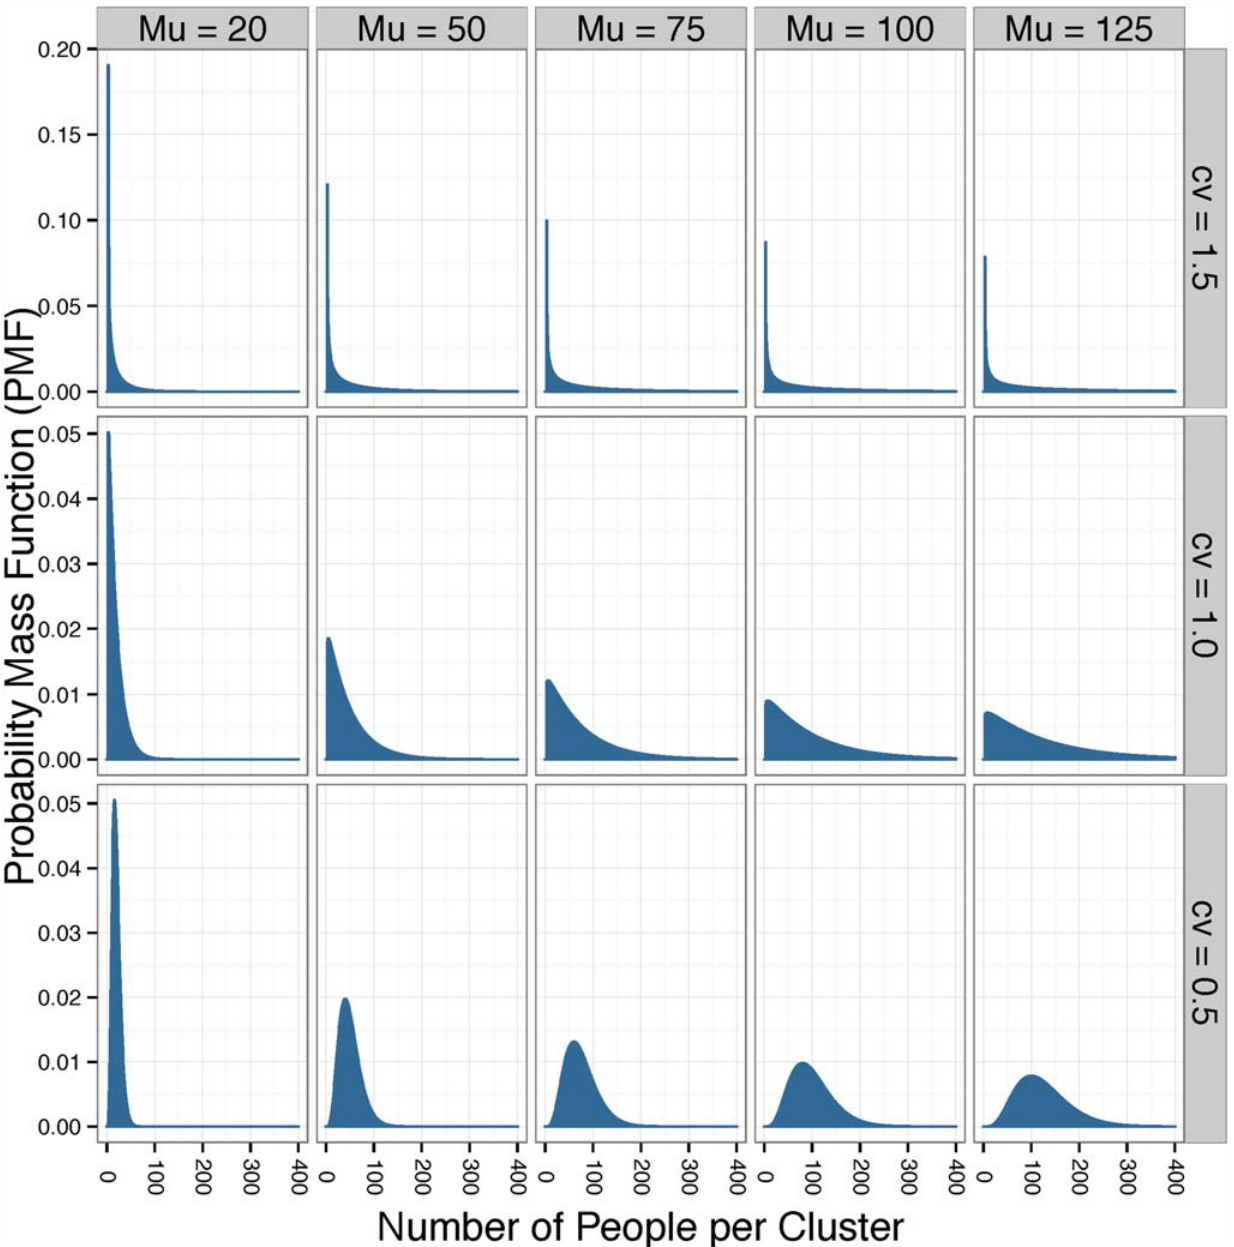
Fig 2. The negative binomial distributions used to draw the cluster sizes sets for each mean cluster size ( μ ) and coefficient of variance ( cv ). Each set had between 5 and 120 clusters, which made up the sample size of a